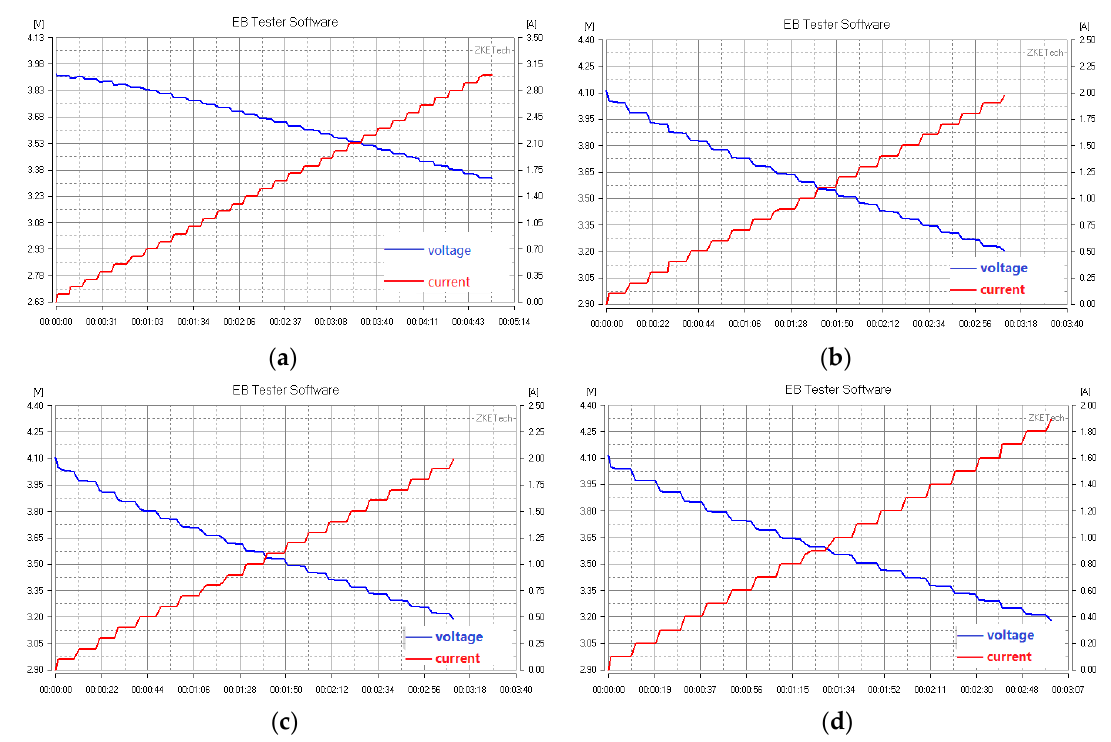
Figure 7. SOF measurement under the step-increasing discharge current. ( a )–( d ) represent voltage vs step-increasing current curves of four different batteries.